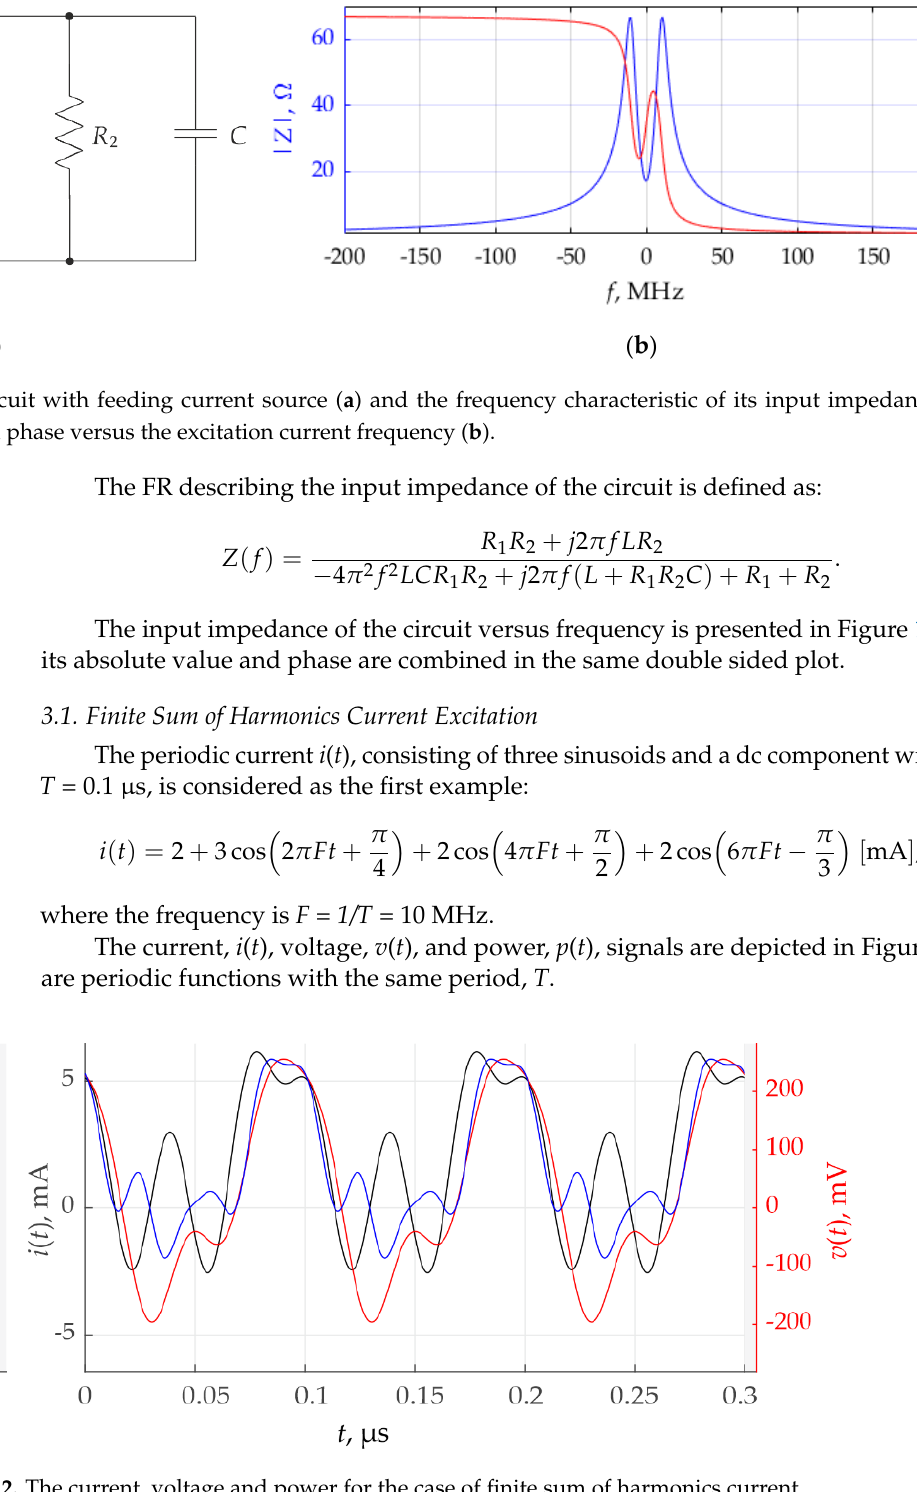
( b ) Figure 3. The current ( a ) and voltage ( b ) spectra for the case of finite sum of harmonics current. It can be seen in Figure 3b that, for the voltage spectra, the maximum in absolute value weights of the delta function are at frequencies ±10 MHz, which correspond to the circuit resonant frequency, f r , and the fundamental frequency, F , of considered signals. Figure 4 shows the weights of two-dimensional Dirac delta functions, forming the bifrequency spectrum, S vi ( f 1 , f 2 ), of the current, i ( t ), and the voltage, v ( t ), in accordance with (15). These delta functions are arranged with step 10 MHz, which corresponds to the fun- damental frequency, F , of signals i ( t ), v ( t ) and p ( t ). It can be seen that the section of S vi ( f 1 , f 2 ) at f 1 = ±10 MHz have maximum weights.